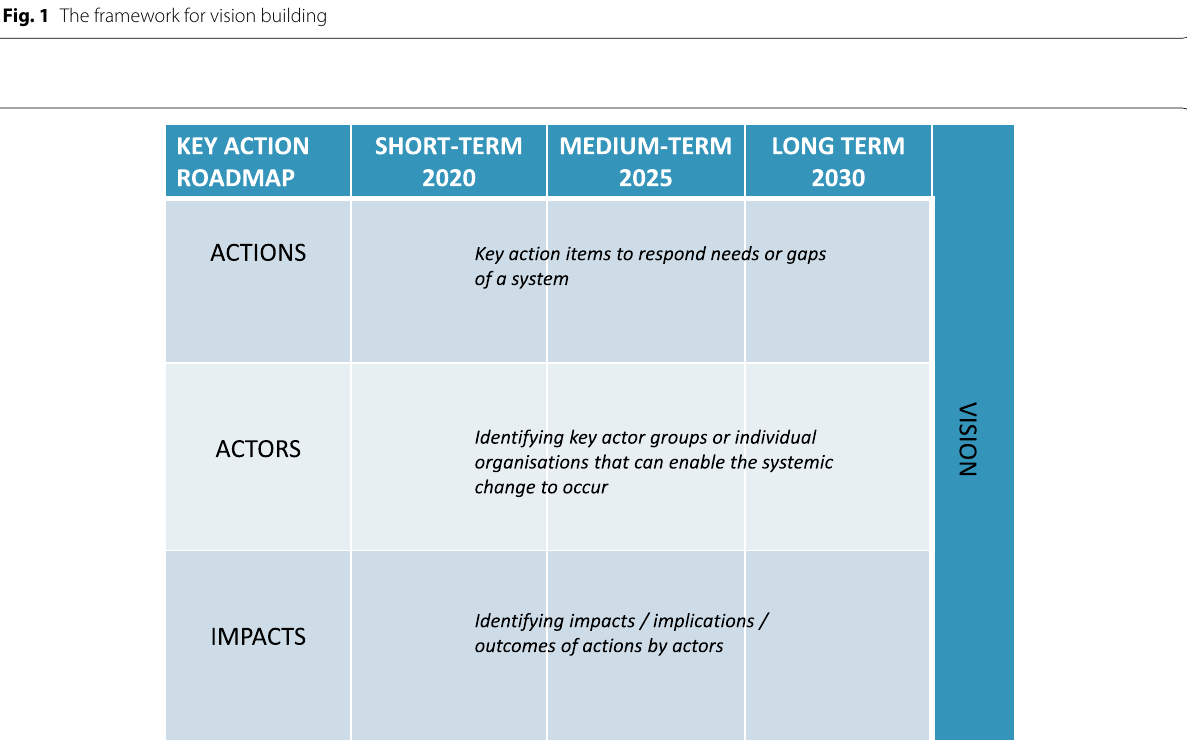
Fig. 1 The framework for vision building